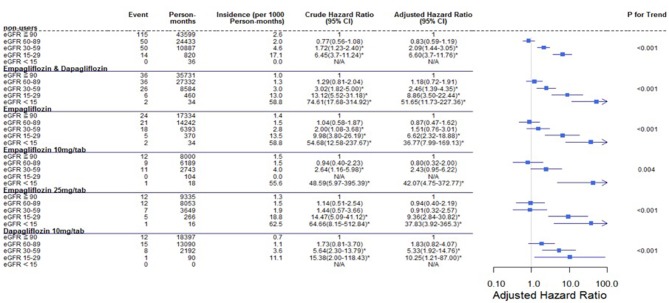
Cox proportional hazard models for AKI-related hospitalization in patients with different renal function levels. The probability of AKI-related hospitalization is shown for eGFR<15, 15–29, 30–59, and 60–89 mL/min/1.73 m2 vs. eGFR ≥ 90 mL/min/1.73 m2 in different SGLT2 inhibitor users and non-users. eGFR, estimated glomerular filtration rate; SGLT2i, sodium–glucose cotransporter 2 inhibitor.